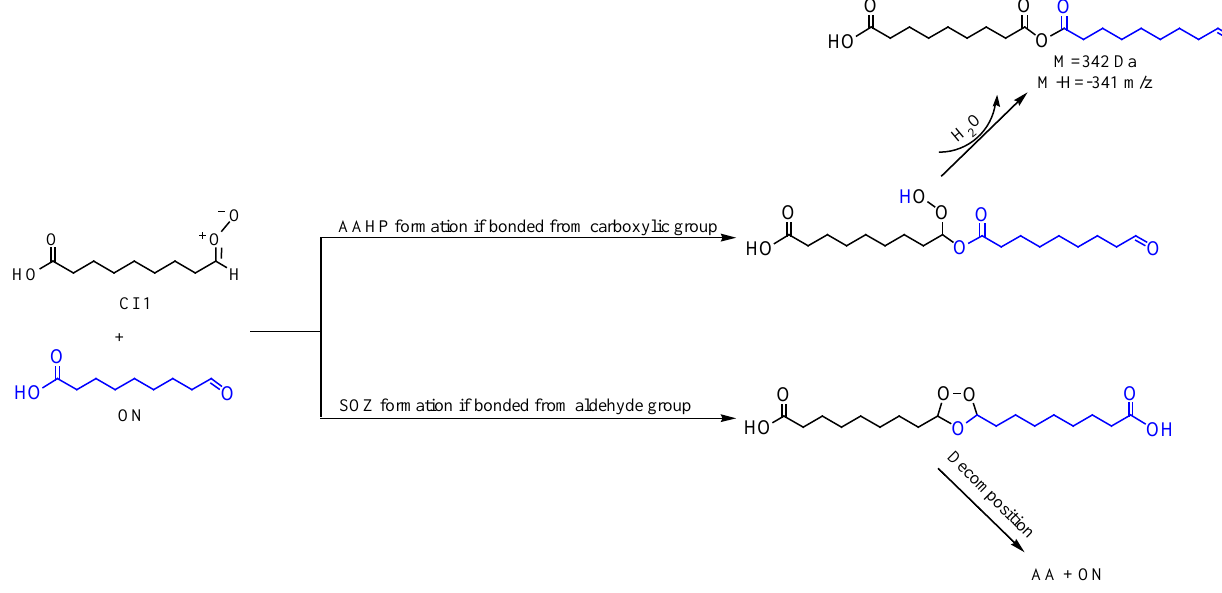
Scheme 3. Suggested reaction pathways and products of the secondary reaction between CI1 and